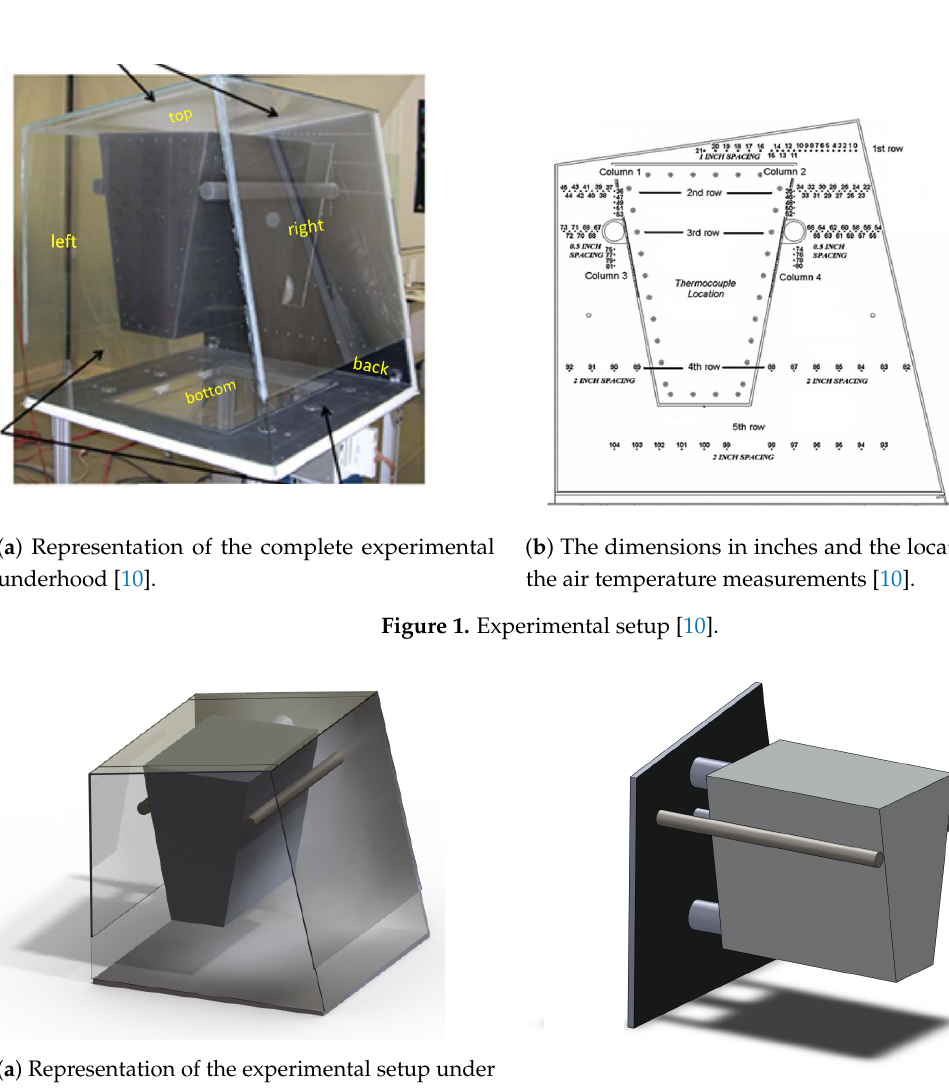
Figure 2. CAD model of the experimental